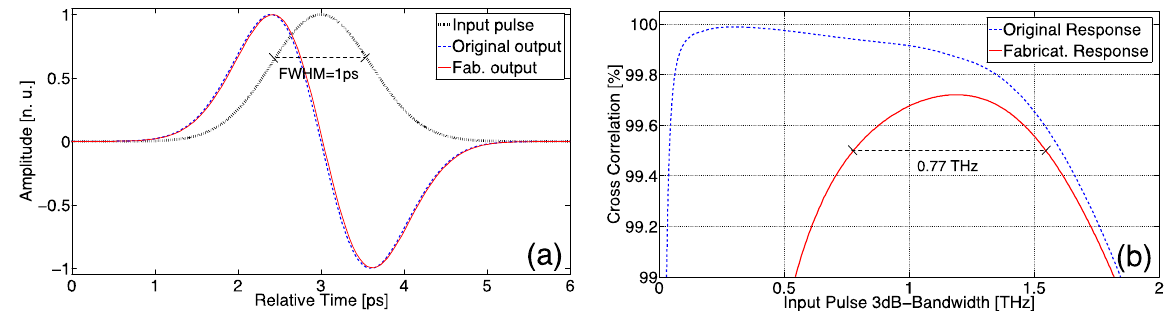
Figure 8. ( a ) Input Gaussian pulse (dotted black line), output of an ideal first-order differentiator (dashed blue line) and output of a first-order differentiator based on a fabrication-constrained FBG in transmission (red solid line); ( b ) Cross-correlation coefficient as a function of the 3 dB-bandwidth of the input pulse for the original design (blue dashed line) and the design tailored to fabrication constraints (red solid line).